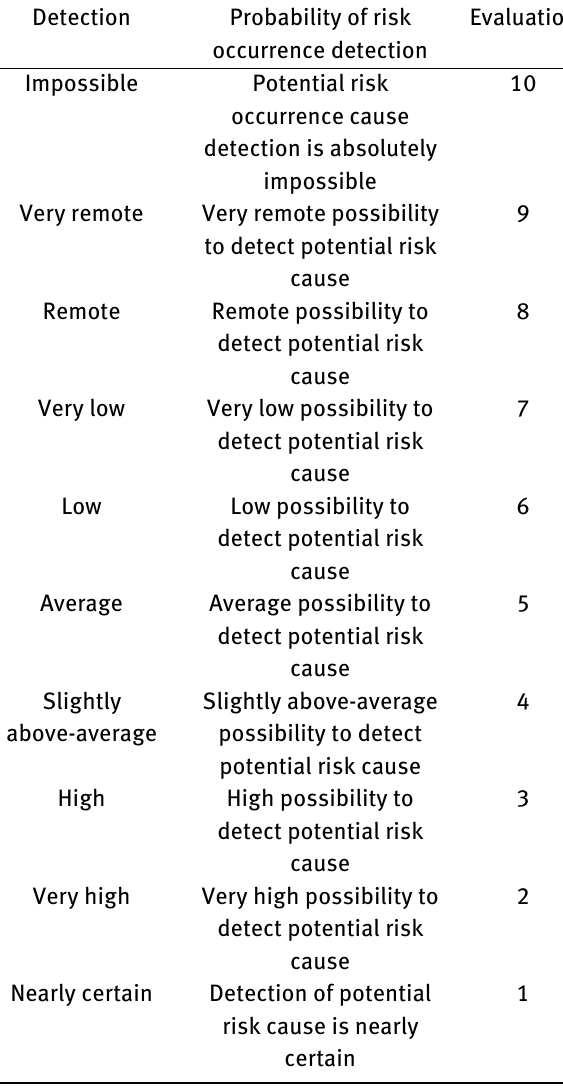
Table 3: Risk occurrence probability assessment (Source: In-house) Risk occurrence probability